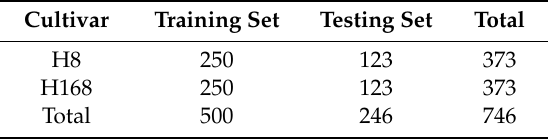
Table 1. The final number of seeds (spectra) for each cultivar utilized in the modeling